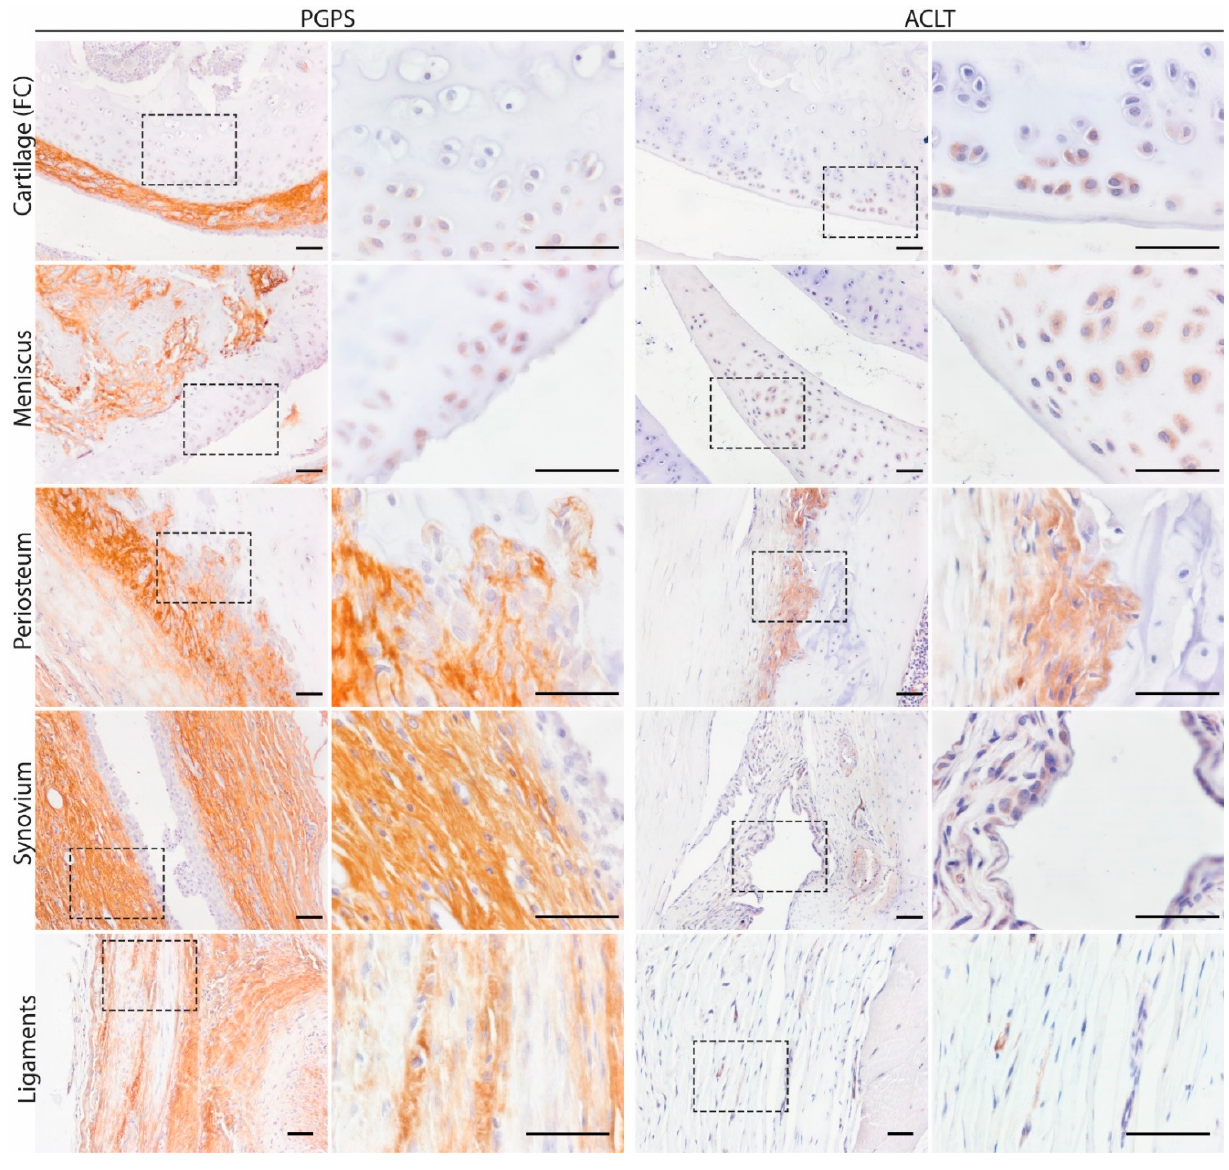
Figure 2. Intra and extracellular OSM expression patterns in acute arthritis and instability induced OA. Representative pictures of OSM expression in different joint structures: Femur condyle (FC) cartilage (chondrocytes, meniscus, periosteum, synovium, and ligaments. Scale bar: 50 µm.